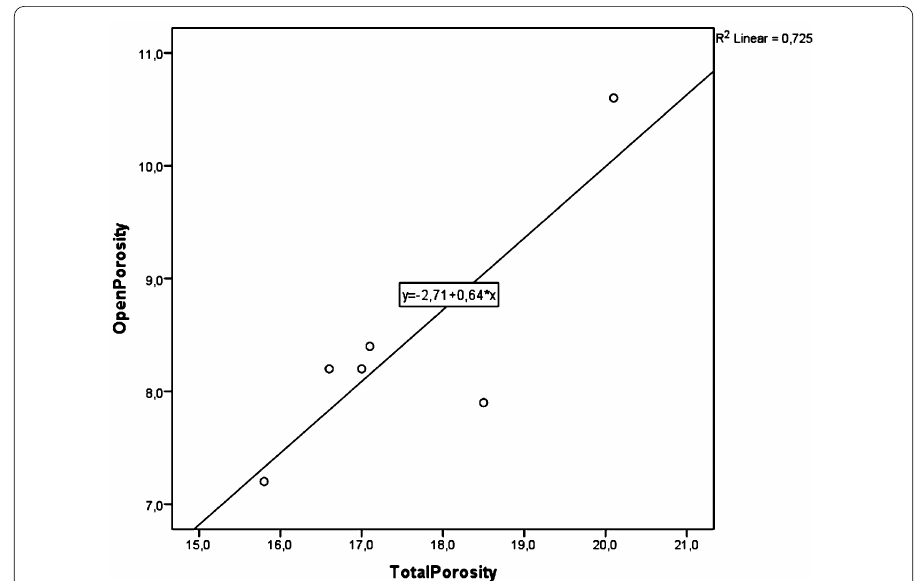
Figure 4 Linear distribution plot of the physical properties of total porosity-open porosity